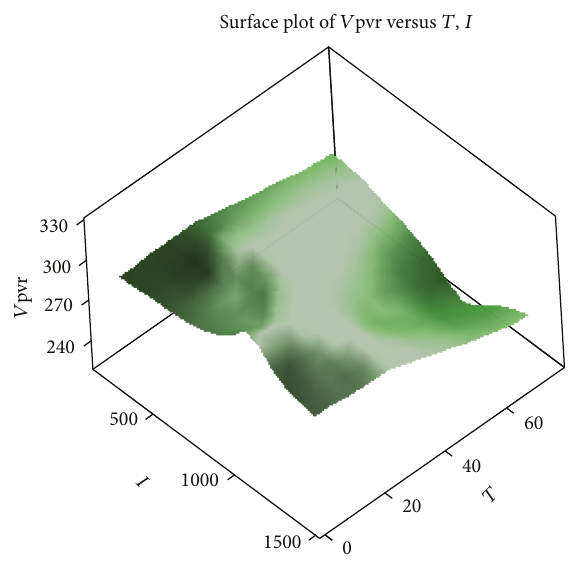
Figure 2: Regression